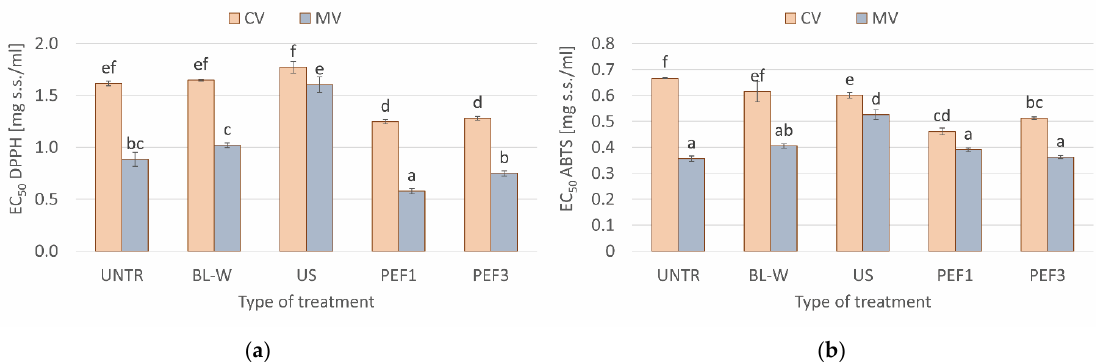
Figure 6. Comparison of antioxidant activity for convective (CV) and microwave – convective (MV) dried red bell pepper subjected to thermal or non-thermal treatment prior to drying, expressed as the effective concentration of the sample (EC 50 ), which can decrease radicals by 50%: ( a ) 1,1-diphenyl-2-picrylhydrazyl radical (DPPH) and ( b ) 2,2-azinobis (3-ethylbenzothiazoline-6-sulfonate) radical cation (ABTS). Column presents a mean (from 3 repetitions), and errors bars show standard deviation. The different letters above columns show different homogeneous groups ( Tukey’s HSD, α = 0.05).